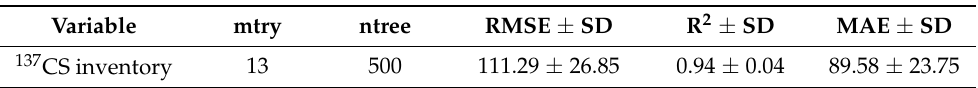
Table 5. Random forest model results between 137 CS inventory as the dependent variable and soil properties as independent variables in the study area.